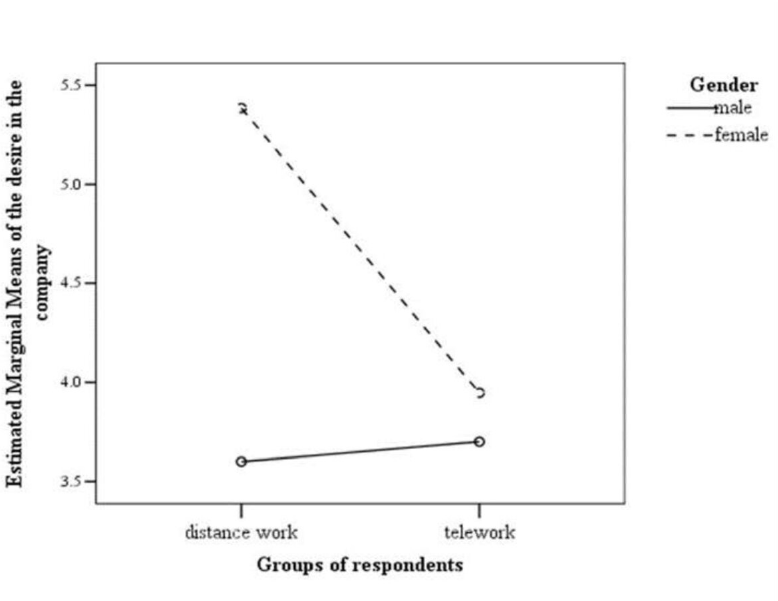
Figure 1: Features of the desire in the company of employees depending on gender and form of labour